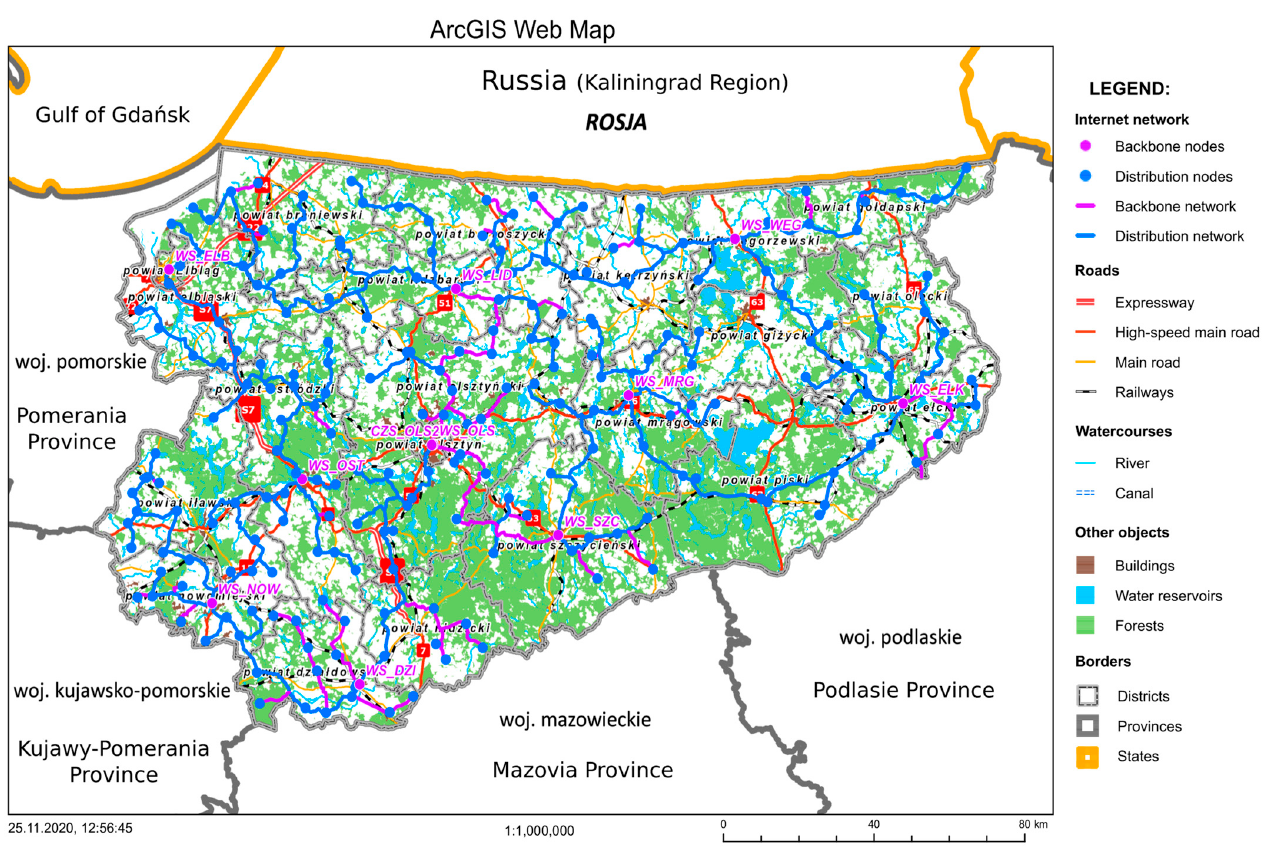
Figure 8. Map of the Warmia and Mazury Province showing the fiber-optic backbone distribution network, the main transport infrastructure and geographical diversity of the area.